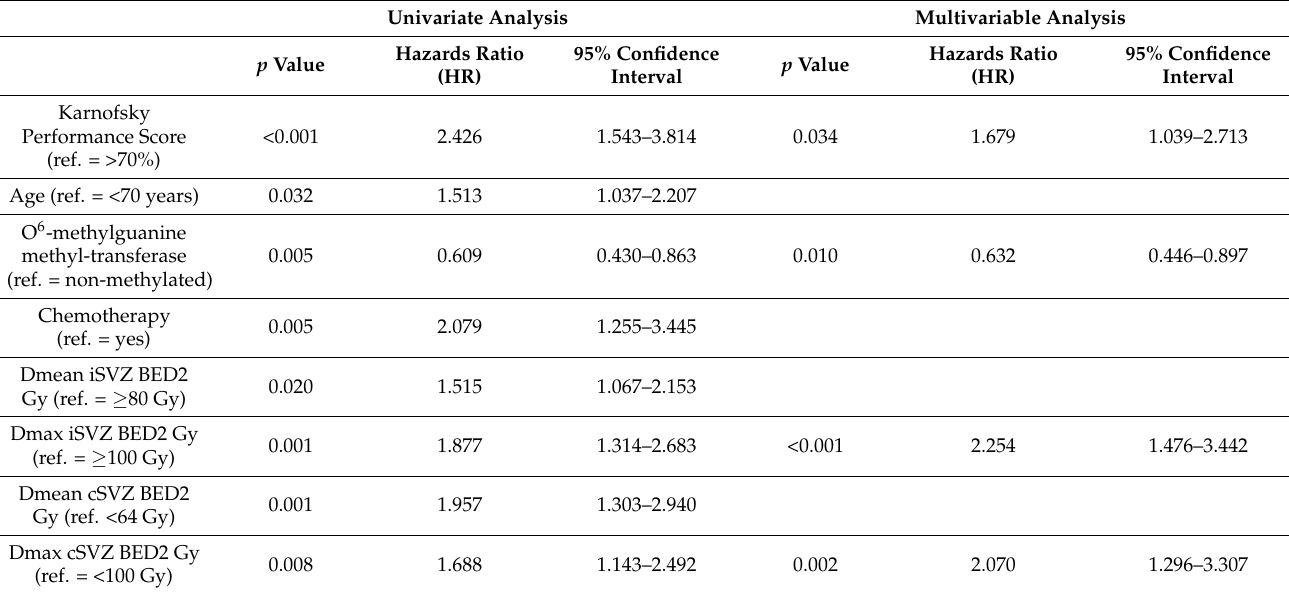
Table 3. Prognostic factors for